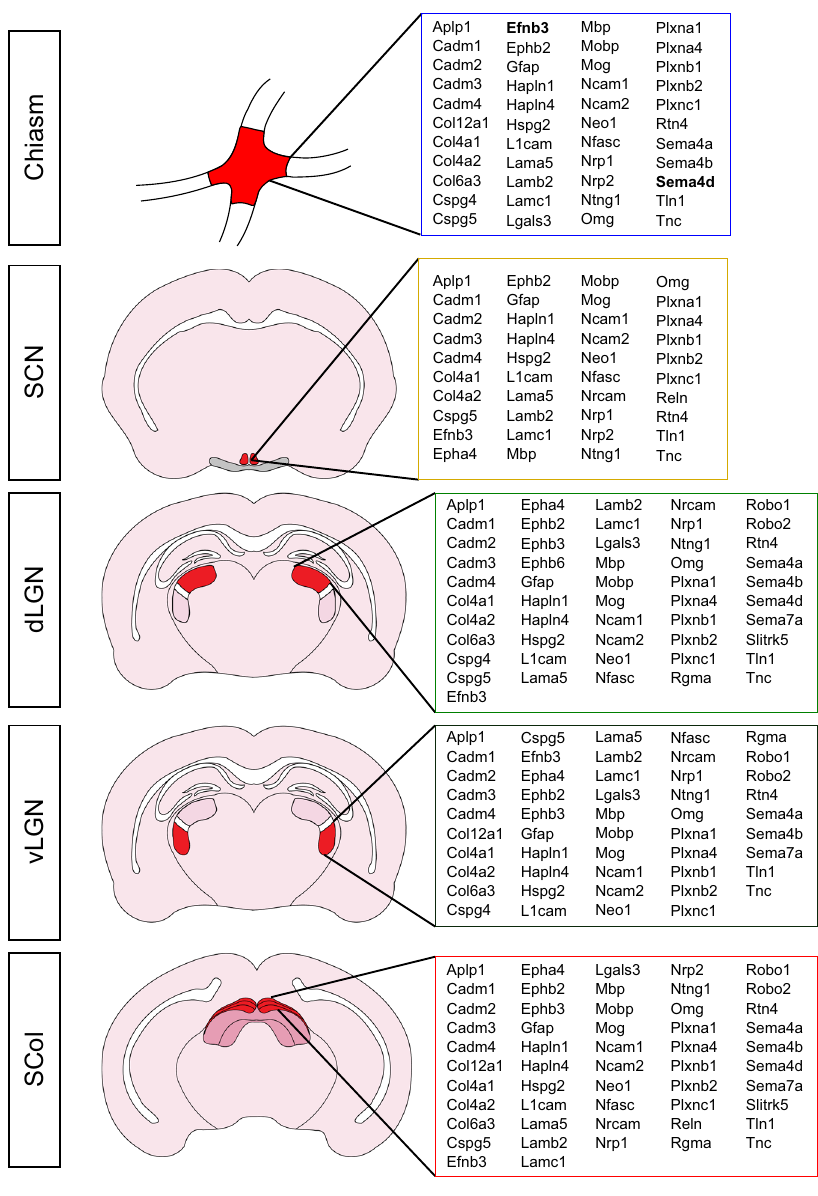
Fig. 6 | Guidance maps in the adult brain targets are set during development and provide insight into the guidance defects encountered by mature regen- erative axons. Summary of guidance maps as described in the present proteomic